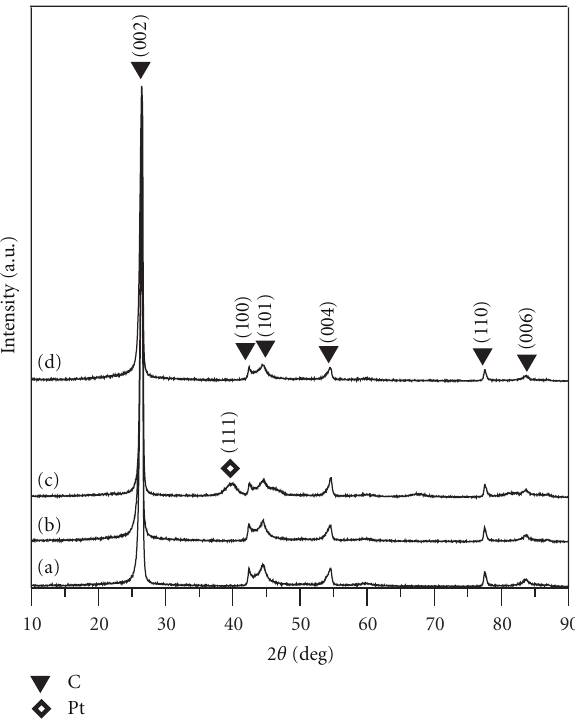
Figure 2: Typical XRD pattern of di ff erent carbon counter elec- trodes: (a) MCMB, (b) C1, (c) C2, and (d) C3.